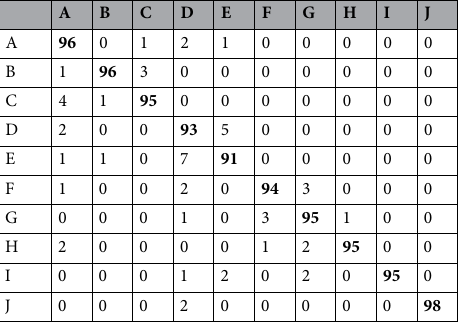
Table 7. Identification confusion matrix of the Northwestern University hand gesture dataset. Significant values are in